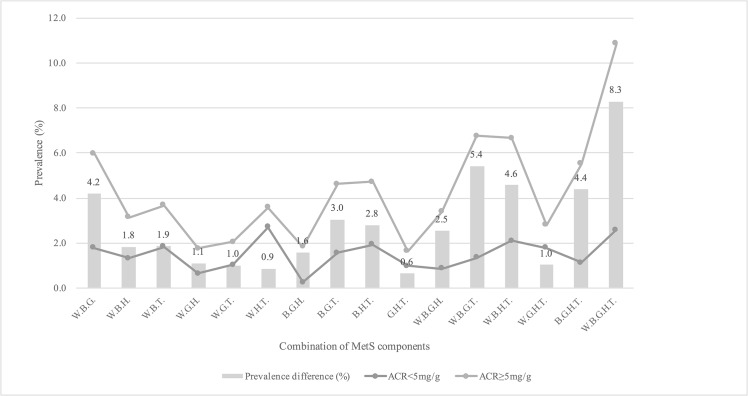
Comparison of the prevalence of MetS using different combination of MetS components with an ACR cutoff value of 5 mg/g.W, high WC; B, high BP; G, high BG; H, low HDL-C; T, high TG; MetS, metabolic syndrome; ACR, albumin-to-creatinine ratio.